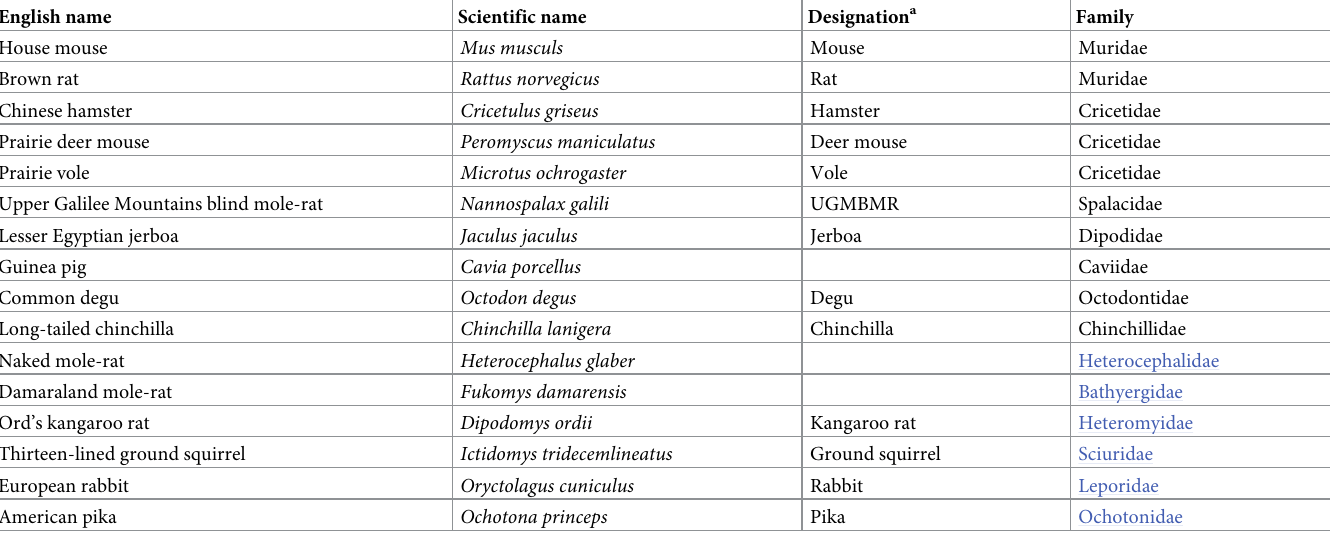
Table 1. Animal species selected for analysis of REST gene